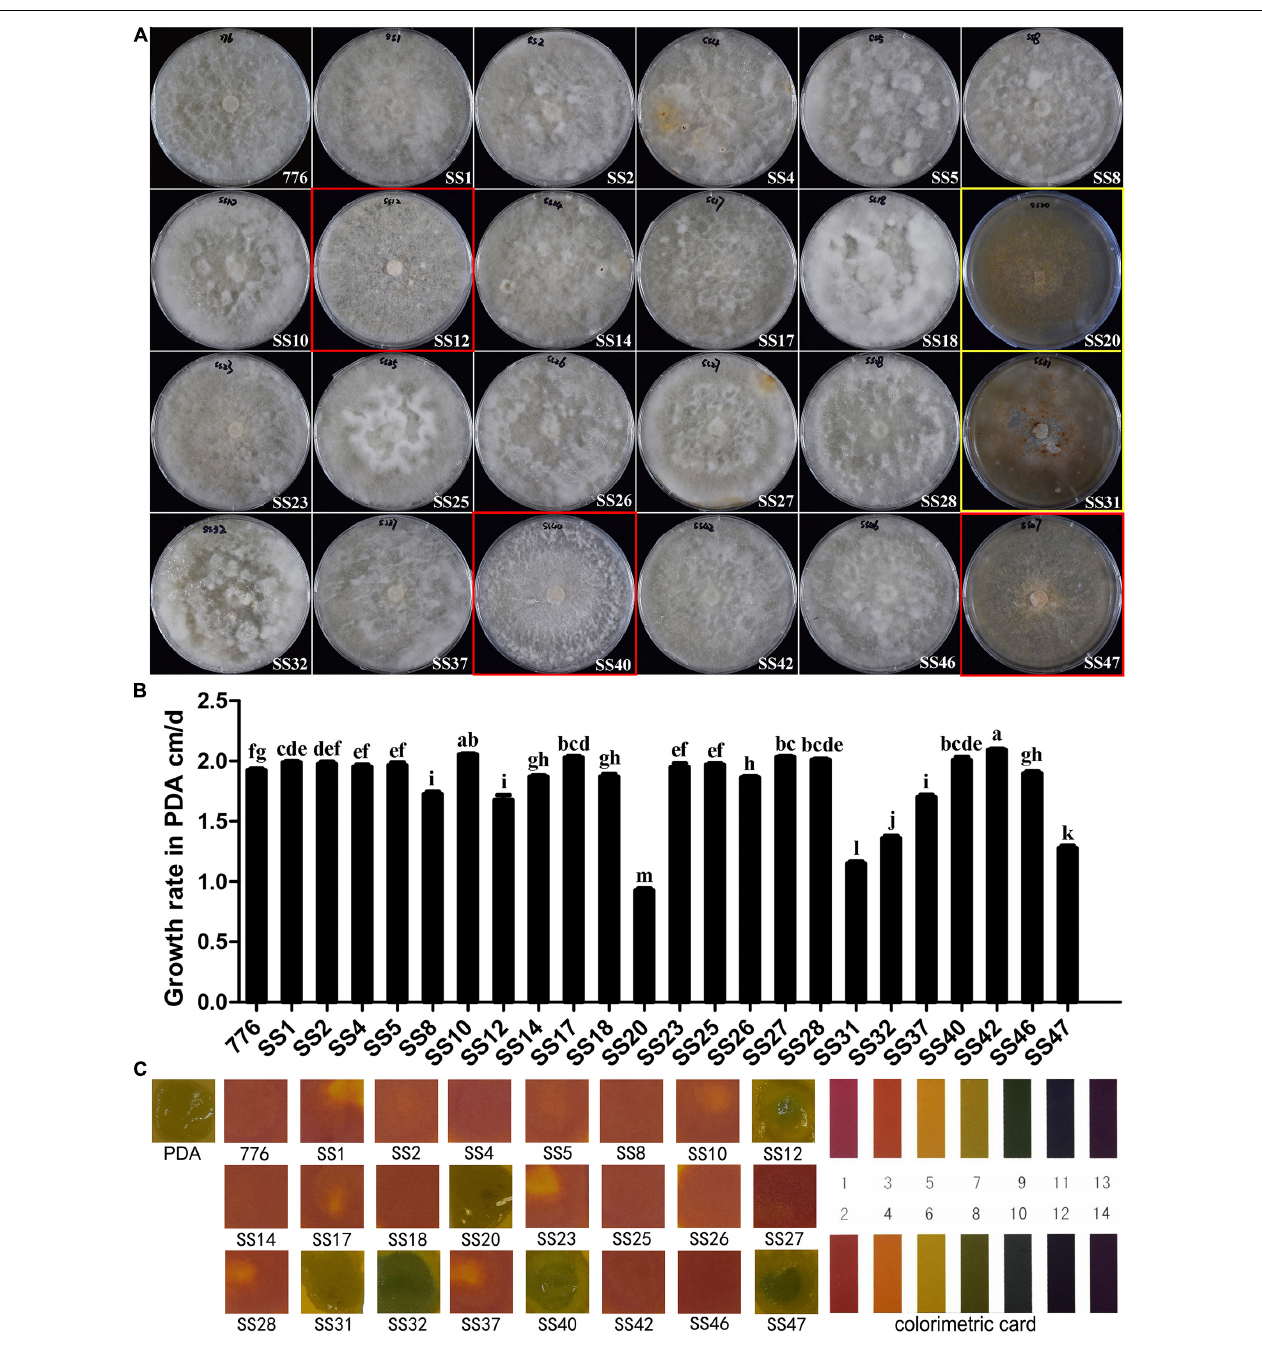
FIGURE 3 | Colony morphology and growth of SSIs in PDA media. (A) Colony of different SSIs and parent strains cultured in PDA medium. White frame: parent-type strain, red frame: creeping-type strain, and yellow frame: brown-type strain. (B) Growth rates of different SSIs and parent strain. Different letters above the bars indicate the significant difference at p = 0.05 by Duncan’s multiple range tests. (C) pH of PDA media in which different SSIs and parent strain grew for 60 days. The pH was measured using pH indicator strips.